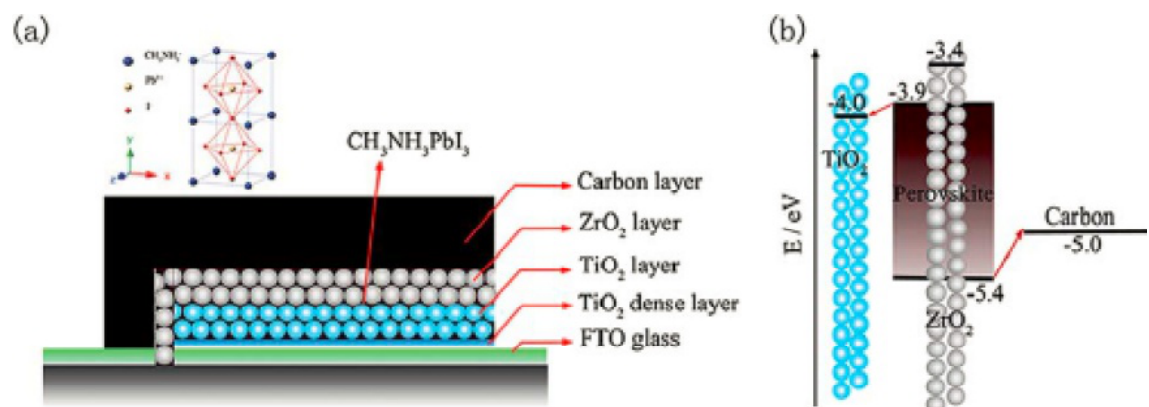
Fig. 12. (a) Structure of device with carbon counter electrode (FTO/c-TiO PbI ) and (b) corresponding energy diagram, reprinted with permission from Y. Yang, K. Ri, A. Mei, L. Liu, x 3 M. Hu, T. Liu, X. Li and H. Han // J. Mater. Chem. A 3 (2015) 9103. © 2015 Royal Society of